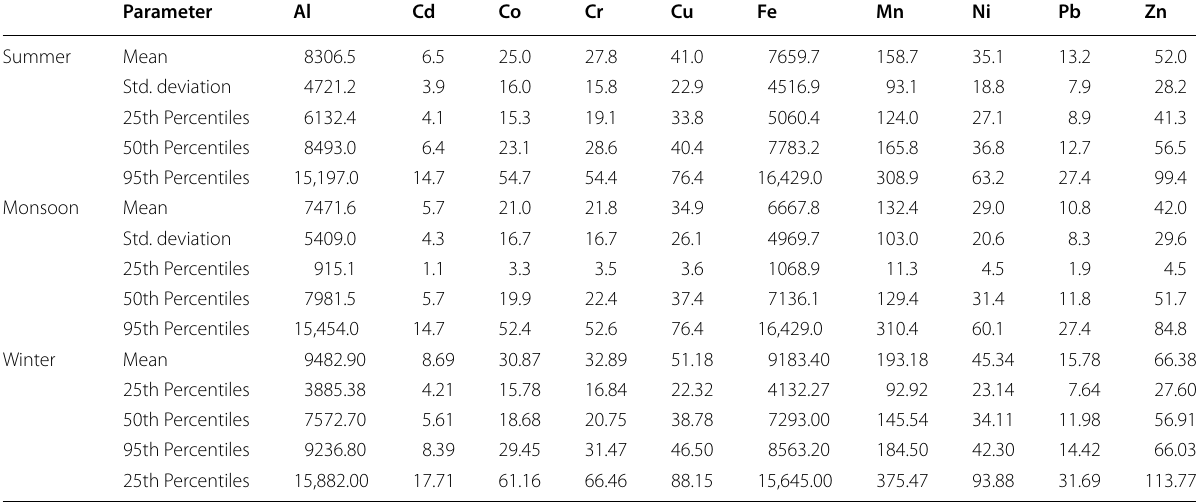
All values are in µg/l